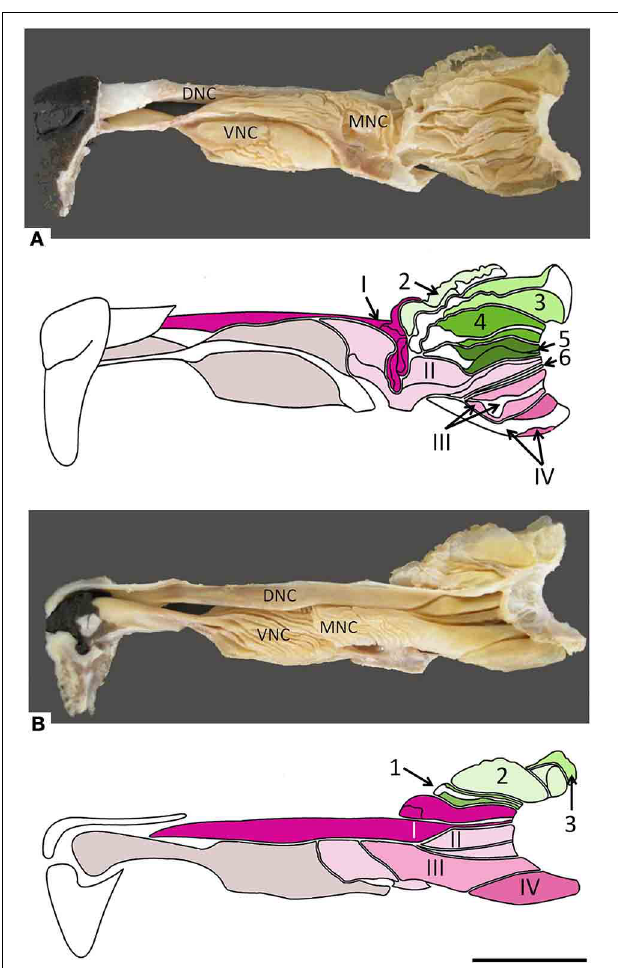
FIGURE 2 | Photographs and schematic drawings of the turbinate complex in lateral (A) and medial (B) views. DNC, dorsal nasal concha; MNC, middle nasal concha; VNC, ventral nasal concha. Ectoturbinates are identified in the drawings by Arabic numerals (1–6) and shades of green, endoturbinates by roman numerals (I–IV) and shades of pink. Scale bar: 2cm (see Figure S2).